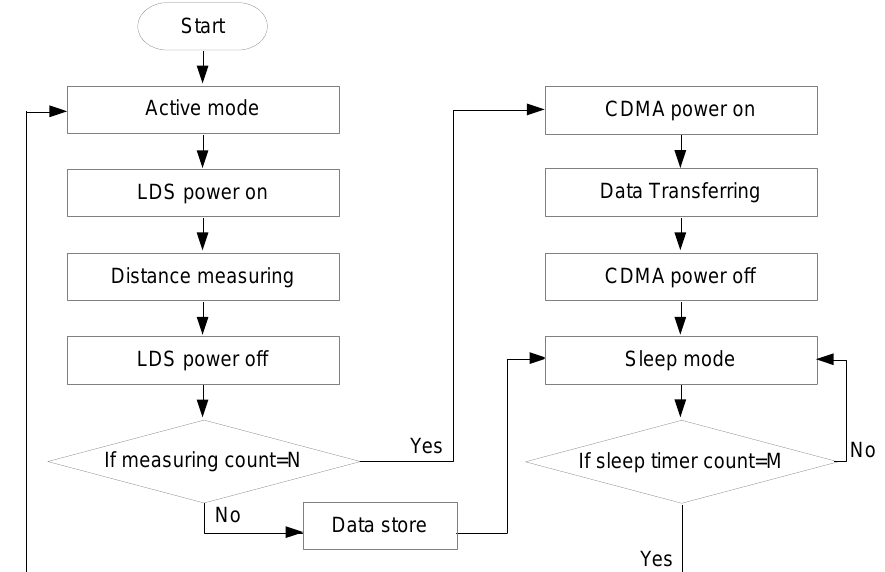
Figure 3. Operation of the wireless laser displacement measurement